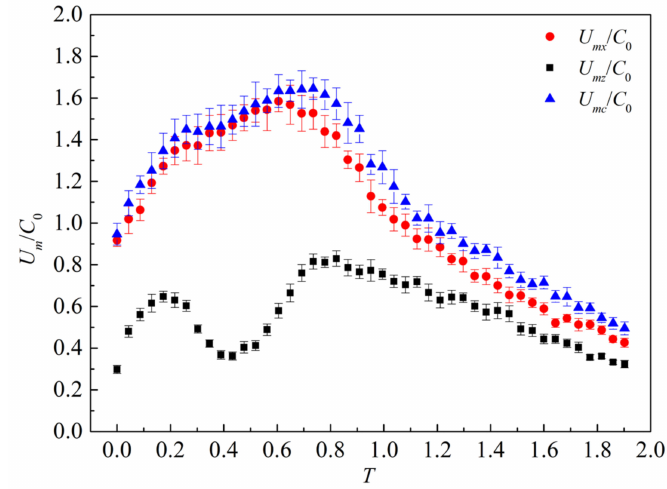
Figure 6. Time history of maximum fluid velocities normalized by the wave velocity of Case 1, D / h = 6/30, H / h = 10/30, C 0 = 0.68